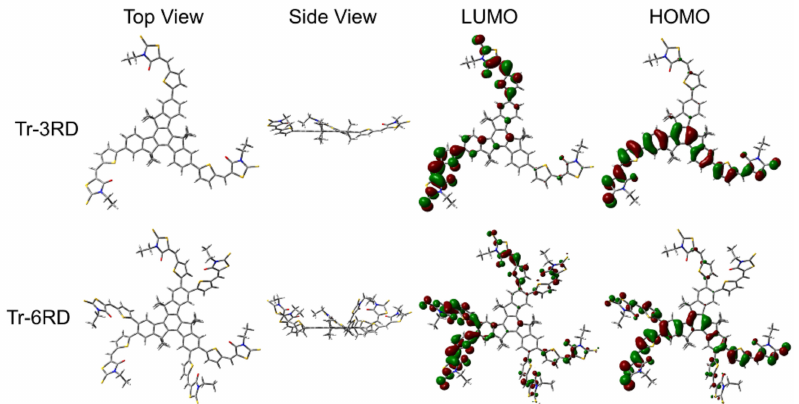
Figure 3. DFT computed molecular geometries and molecular frontier orbital for the model structures (Tr-3RD and